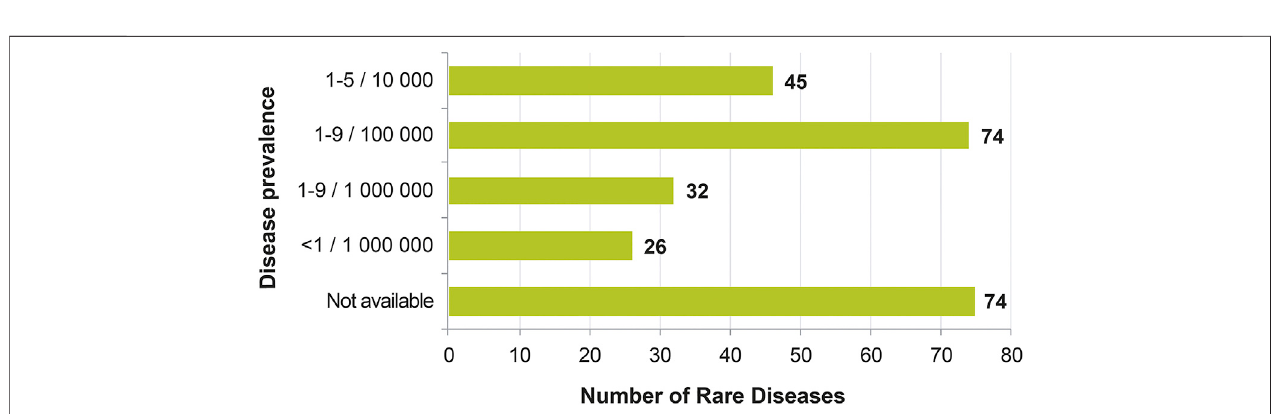
FIGURE4 | Distribution ofthe classes ofprevalence ofthe rare diseases for which adelayed diagnosis would be especially detrimental, in thecontext ofthe study.